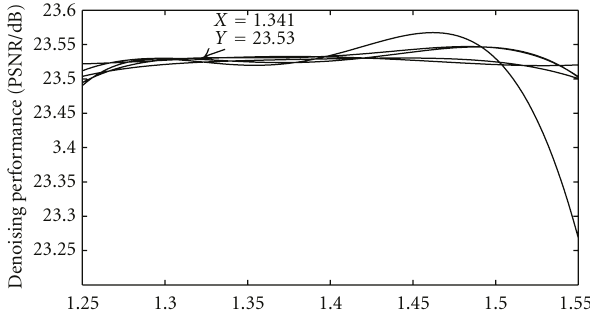
Figure 7: The results of image denoising.